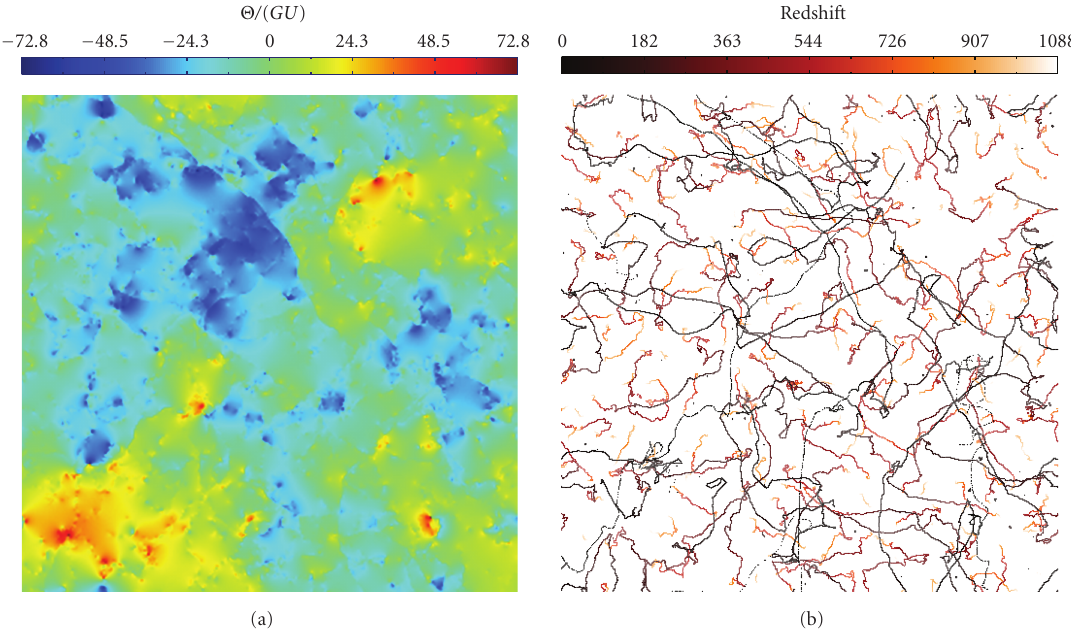
Figure 13: String-induced CMB temperature fluctuations on a 7 . 2 ◦ field of view [46]. Because of their cosmological scaling, most of the long strings intercept our past light cone close to the last scattering surface. As can be seen in the right image, the edges in the temperature patterns can be identified to strings intercepting our past light cone. Note that active regions corresponding to string intersection and loop formation events lead to the bright spots in these maps.